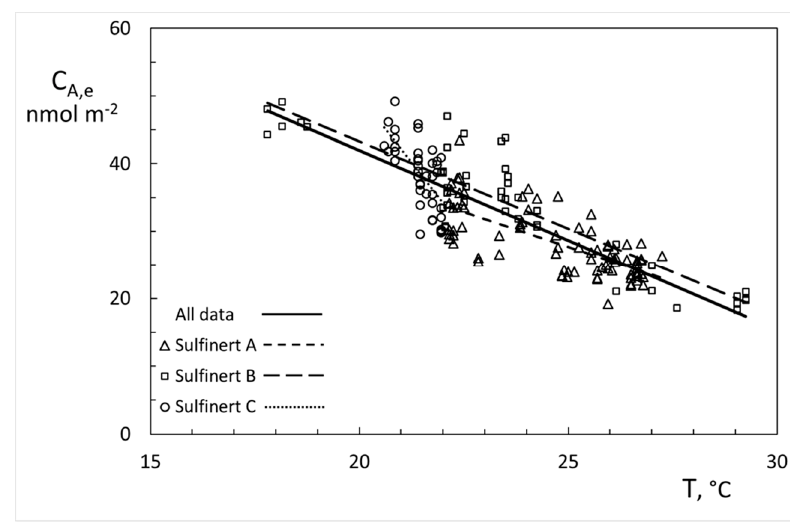
Figure 4. Sensitivity of adsorbed amount per unit area on temperature.